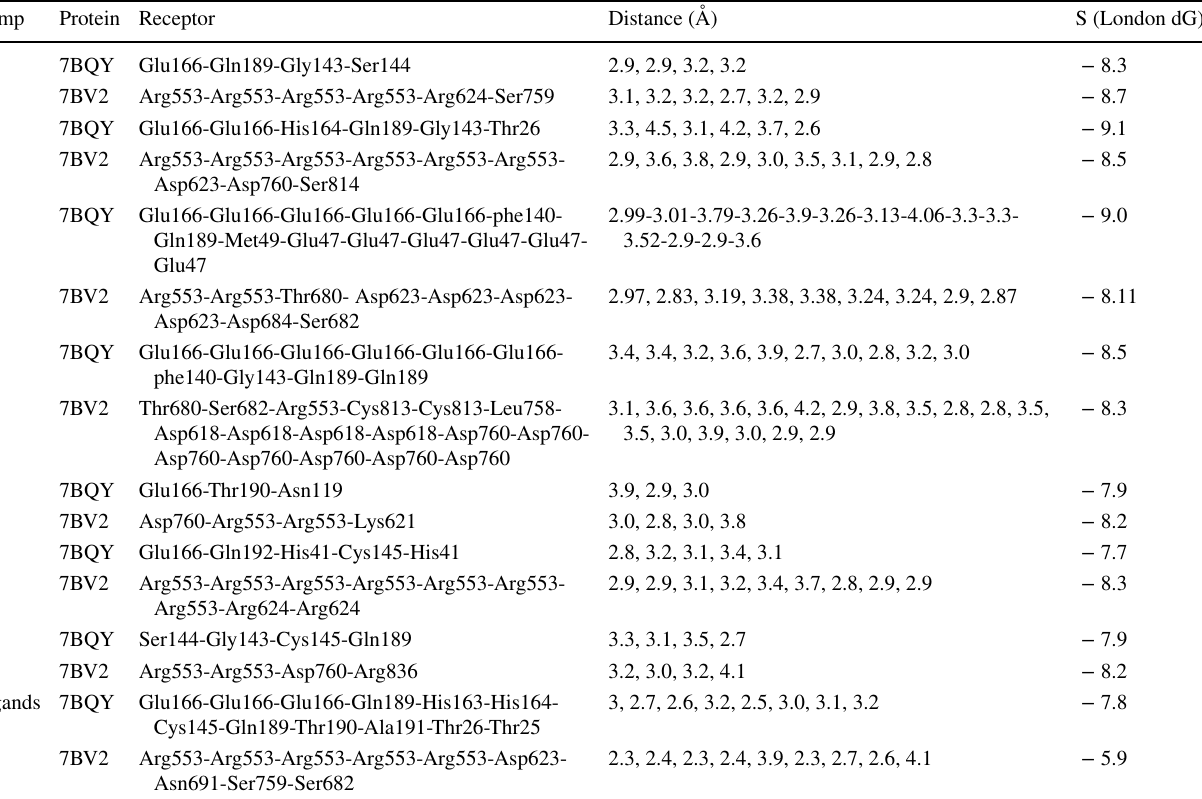
Table 2 MOE binding energies S (Kcal mol −1 ) of best binding pose for compounds 3, 16, 23, 24, 25, 29, 40 and native ligands into 7BQY and 7bV2 (London dG as score